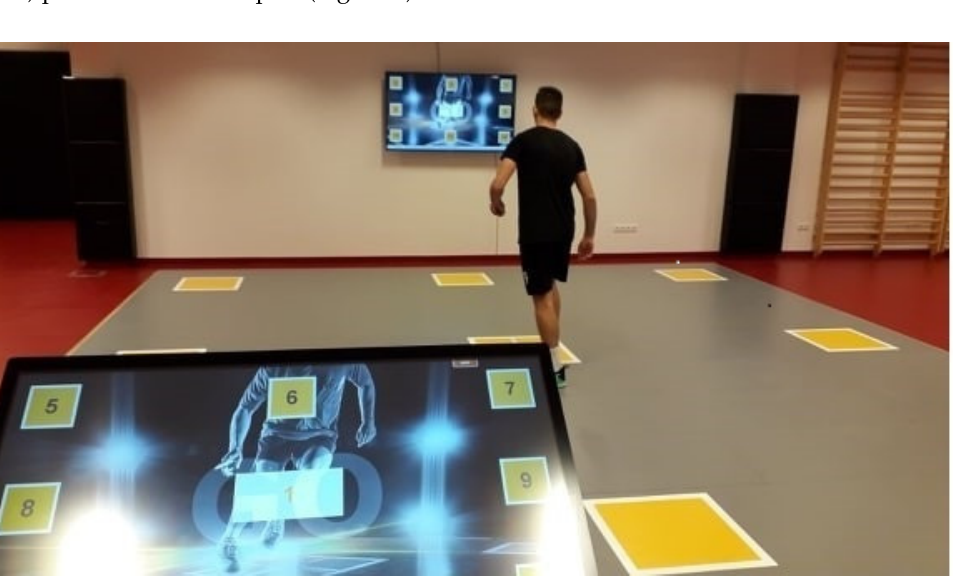
Figure 3. The SpeedCourt System.